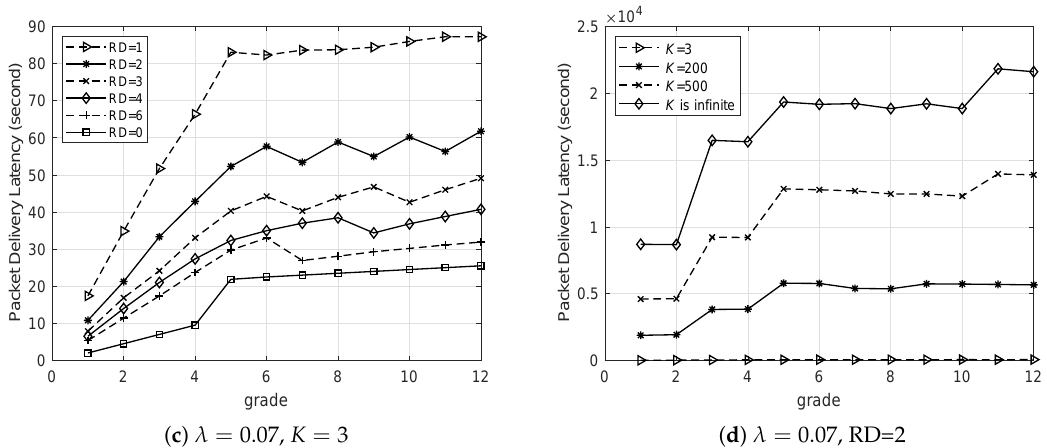
Figure 9. Packet delivery latency versus grade with different packet arrival rates ( λ ) and queue lengths ( K